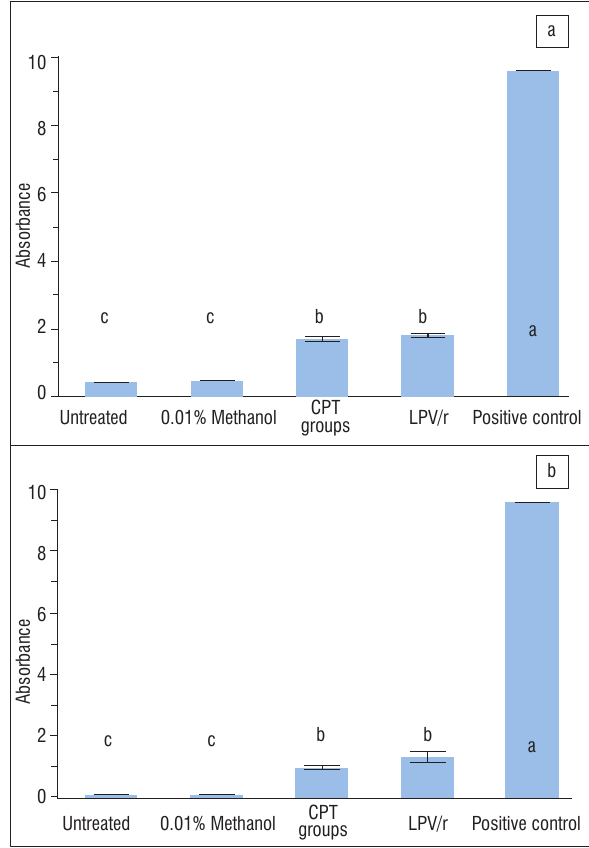
Figure 6: Effects of LPV/r on CPT mediated apoptosis in MCF-7 and MCF-10A cells evaluated by the Cell Death Detection ELISA. (a) MCF-7 and (b) MCF-10A cells were treated with methanol or LPV/r for 96 h and stimulated with CPT (1 µM and 30 µM, respectively) and apoptosis was assessed by quantifying internucleosomal DNA fragmentation. LPV/r treatment did not significantly ( p <0.05) inhibit CPT induced apoptosis in both cell lines. Levels not connected by the same letter are significantly different from each other.